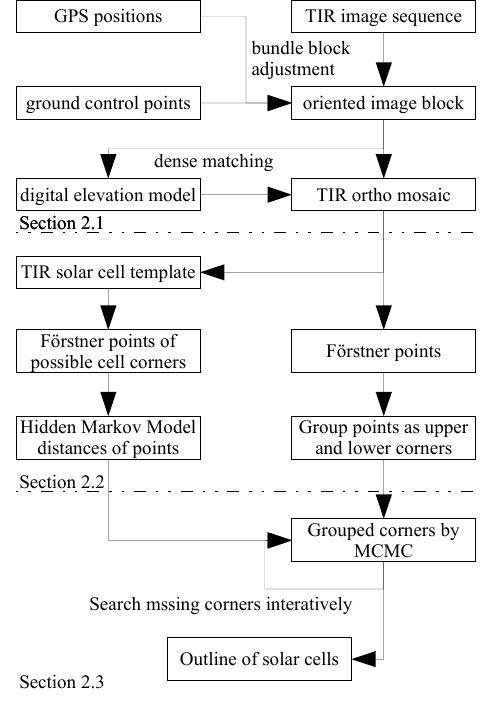
Figure 1. Overview of the proposed